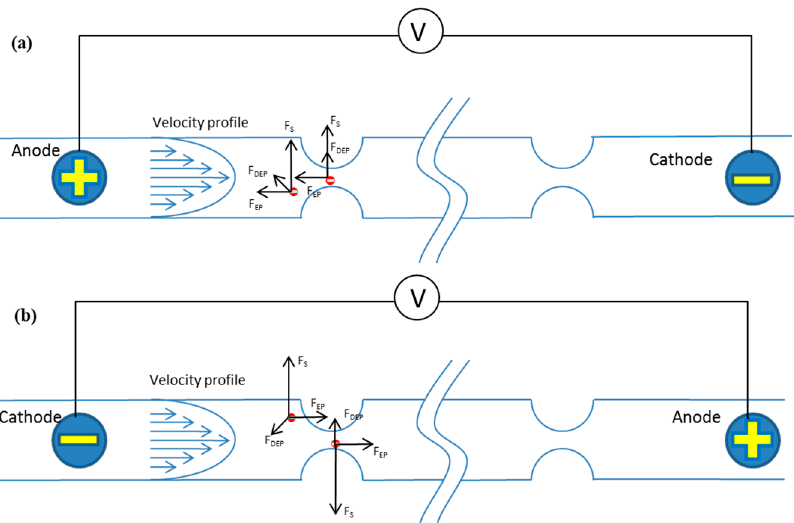
Figure 2. Schematic of tunable particle focusing in a straight channel with symmetric semicircle obstacle arrays using electrophoresis (EP)-modified inertial effects. ( a ) The principle of radially-inward (toward the channel center) migration of particles by the electrophoresis-induced Saffman force; ( b ) The principle of radially-outward (toward the channel wall) migration of particles by the electrophoresis-induced Saffman force.